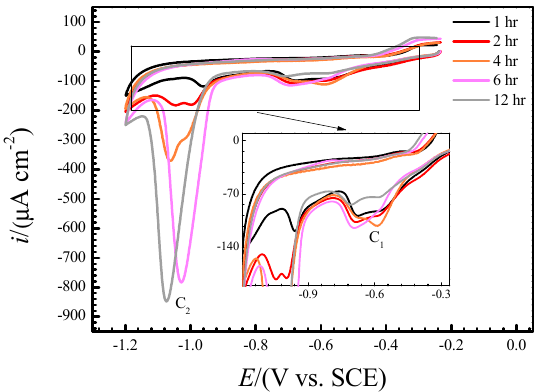
Figure 7. Voltammograms that swept from the OCP to 1.2 V and then reversed to OCP of copper